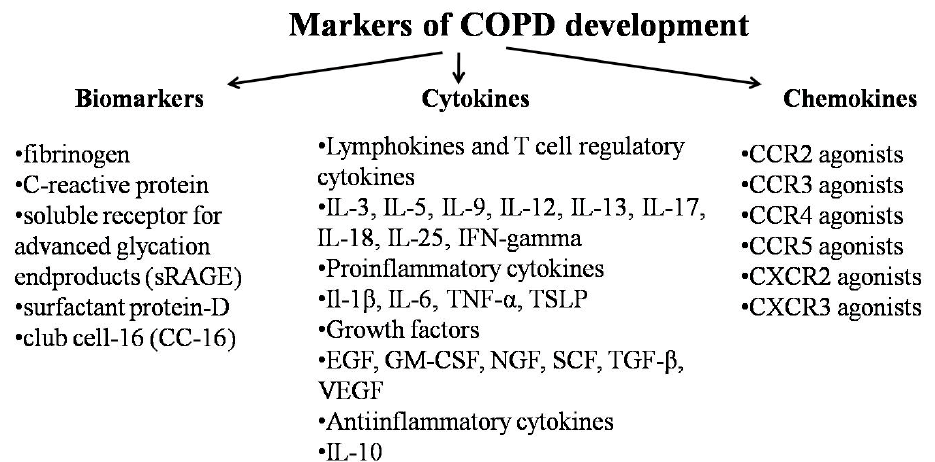
Figure 3. Classification of the most frequently listed markers during COPD.